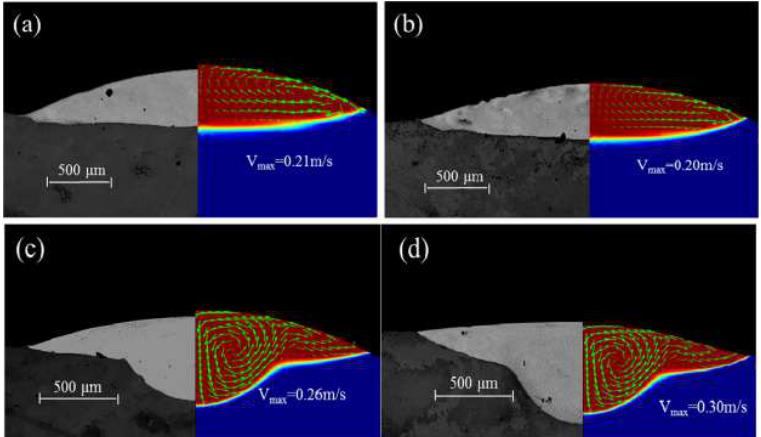
Figure 4. Experimental and calculated geometry of melt pool (y-z plane) under different mass flow rates: ( a ) 6 g/min; ( b ) 4 g/min; ( c ) 2 g/min; ( d ) 0.1 g/min [54].